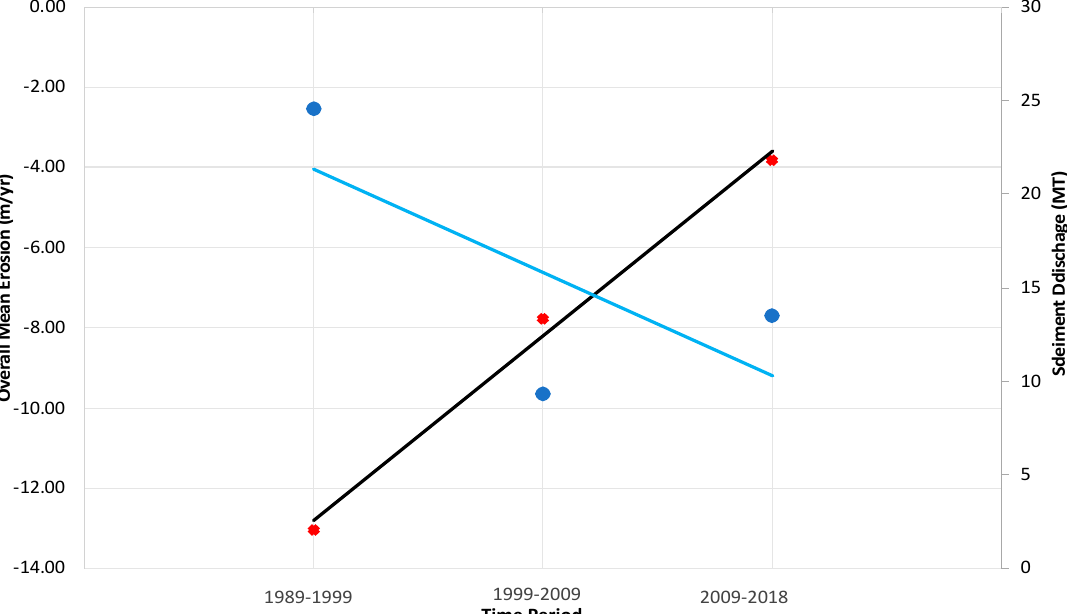
Figure 10. Overall trend of the mean changes in the sediment discharge (MT, 1 ton = 0.98 metric ton) downstream Kotri Barrage of IR catchment (blue color line) vs. overall trend of the mean erosion of the barrier islands (black color line) of the study area during the study period. Red points are representative measures of mean erosion of barrier islands and the blue points are the representative measures of the mean changes in the sediment discharge. Protecting BIs for effective coastal adaptation.